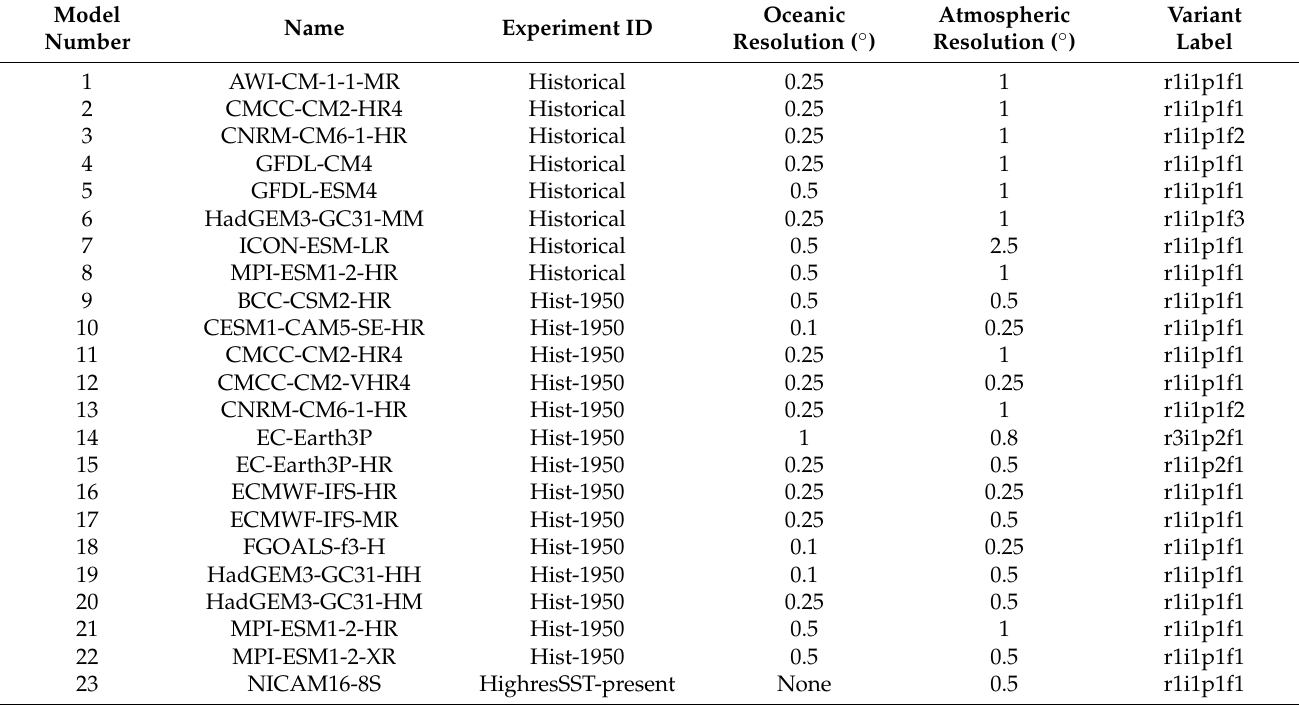
Table 1. List of the Global Climate Models (GCMs) from the CMIP6 project